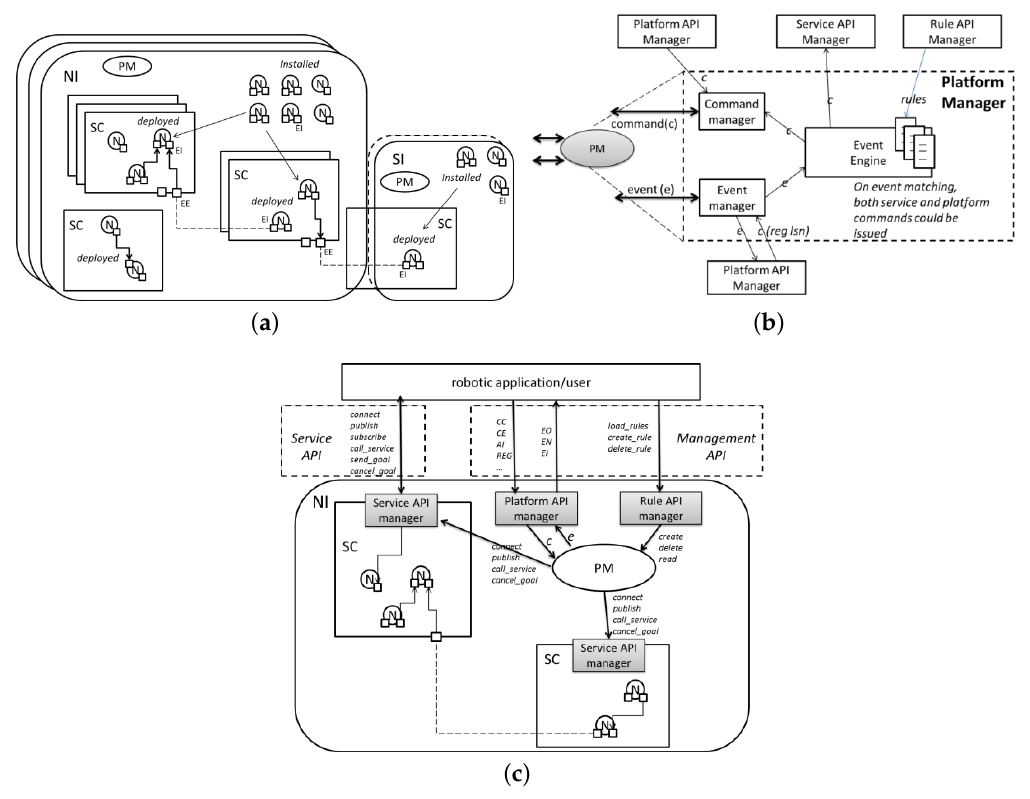
Figure 2. The cloud robotics platform developed by TIM. ( a ) The platform objects and their relationships; ( b ) the platform manager logic architecture; ( c ) the